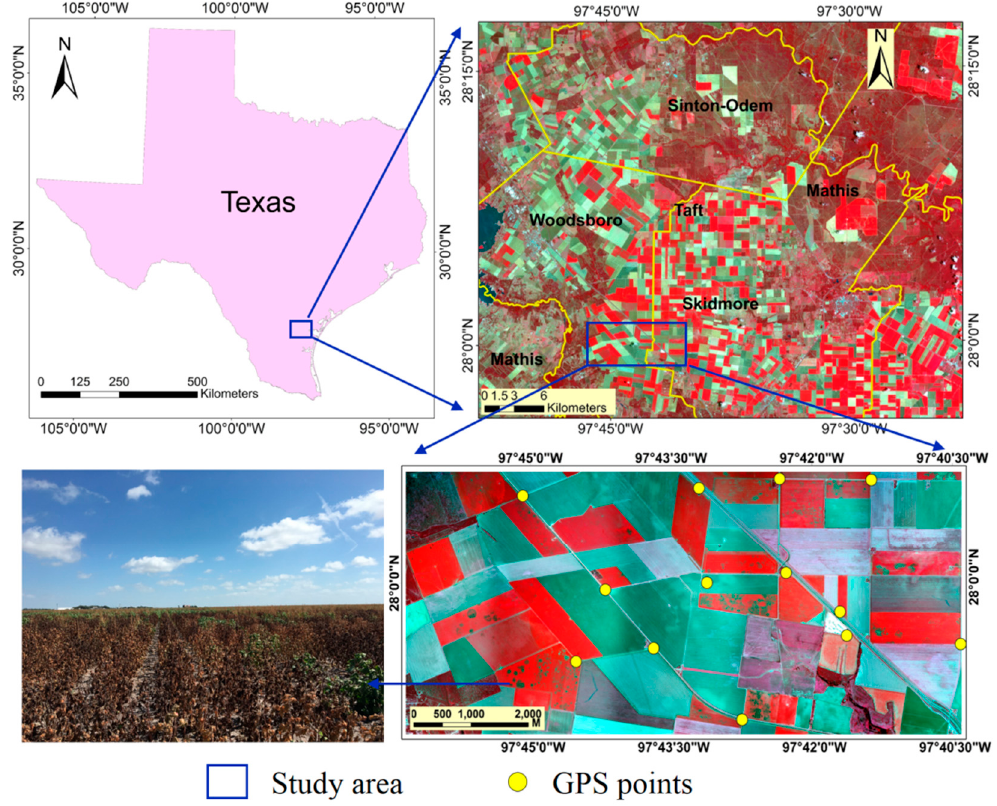
Figure 1. Location of the study area.